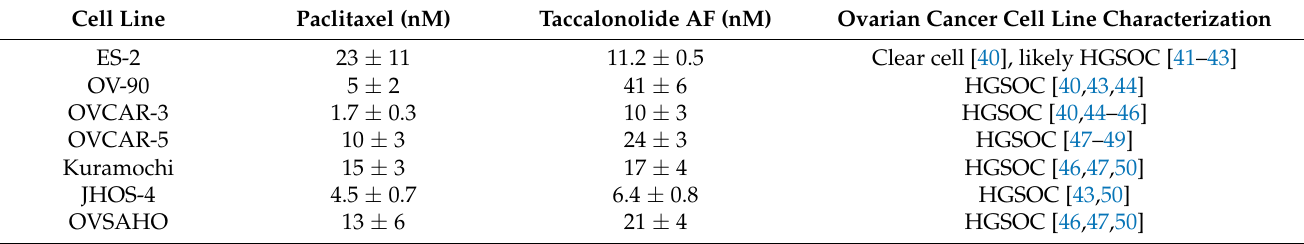
Table 3. GI 50 (nM) of paclitaxel and taccalonolide AF in a panel of ovarian cancer cell lines. Mean ± SEM n = 3–7. Cell Line